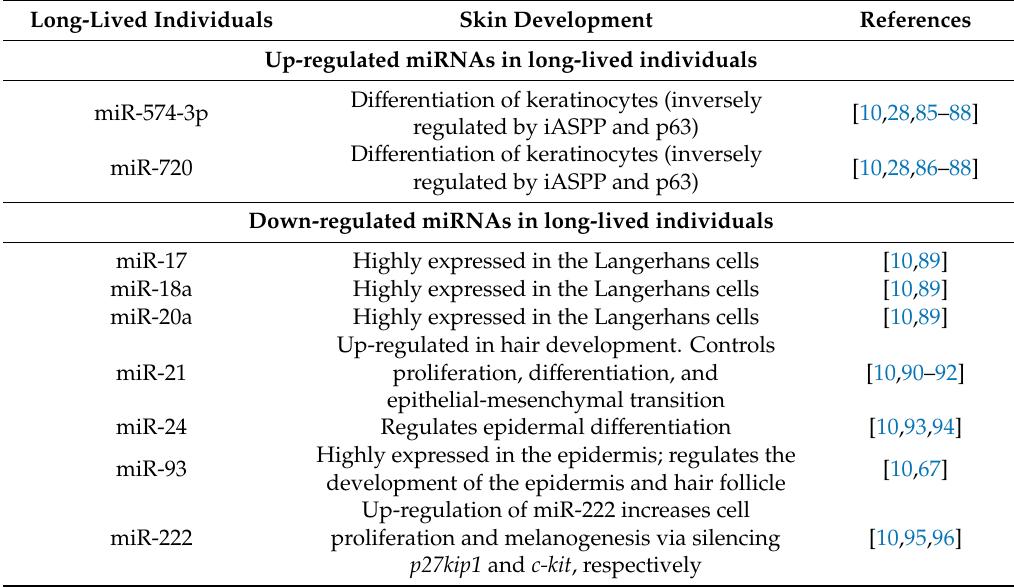
Table 1. The di ff erentially expressed microRNAs (miRNAs) in the skin of long-lived individuals and their role in normal skin